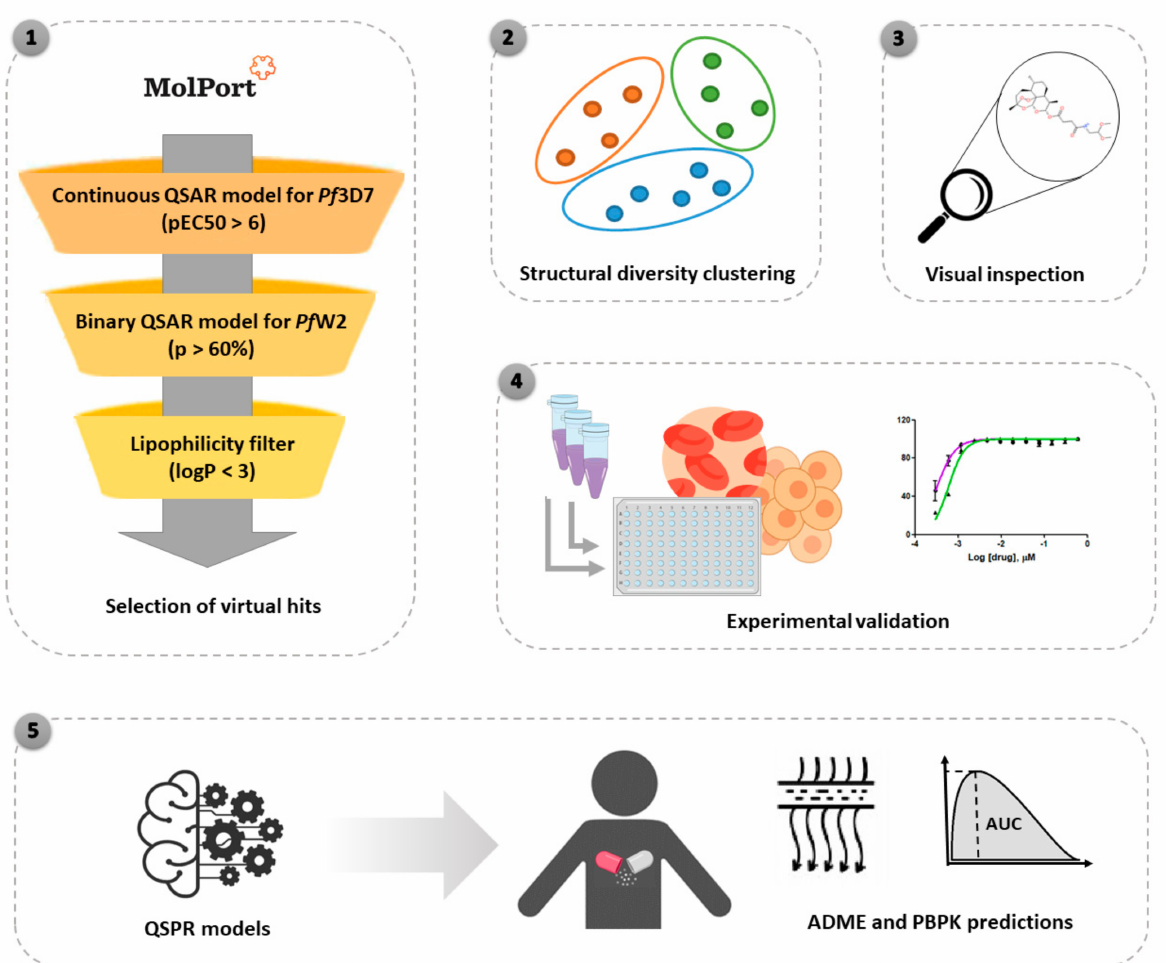
Figure 1. General workflow of the virtual screening of natural compound database followed by experimental validation. The following steps were conducted: ( 1 ) quantitative structure–activity relationship (QSAR)-based virtual screening of MolPort natural products and derivatives database and selection of compounds with best predicted antimalarial activity; ( 2 ) analysis of structural diversity by clustering; ( 3 ) visual inspection; ( 4 ) experimental validation against P. falciparum blood stages and mammalian HepG2 cells and ( 5 ) quantitative structure–property relationship (QSPR) models for prediction of absorption, distribution, metabolism, and excretion (ADME) and physiologically based pharmacokinetic (PBPK)